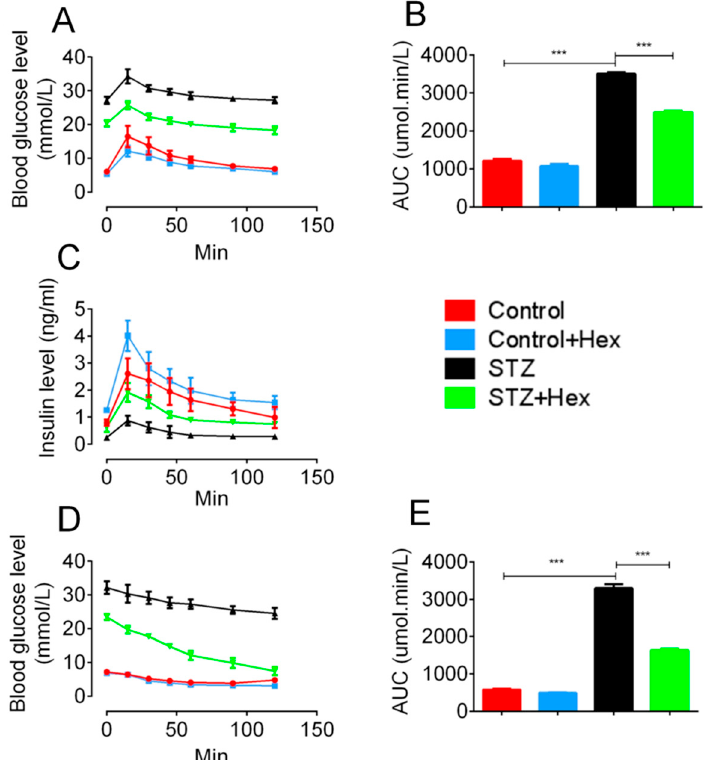
Figure 3. GTT and ITT in control, control + Hex, STZ, and STZ + Hex rats. Glucose tolerance tests and insulin tolerance tests were performed in rats with STZ and/or Hex treatment. Results of ( A ) GTT, ( C ) GTT insulin, and ( D ) ITT are shown at different time points. Corresponding analysis of the area under curve of ( B ) GTT and ( E ) ITT exhibited glucose intolerance and insulin insensitivity of STZ group, which recovered by Hex treatment. n = 8, data are shown as the mean ± SEM. *** p < 0.001.